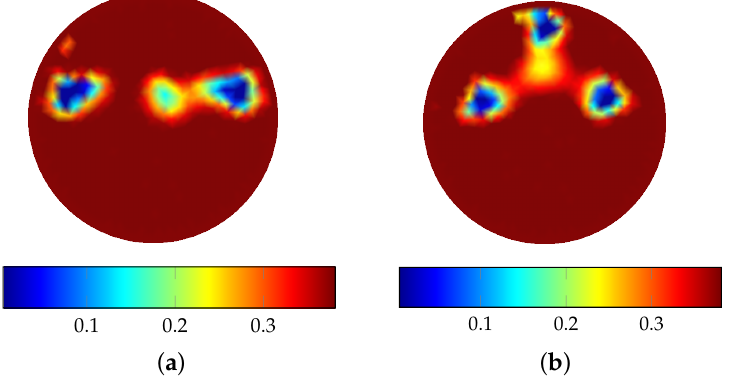
m ) − 1 . ( a ) Linear arrange- m ) − 1 . (a) Linear · m ) − 1 . (a) Linear · ·